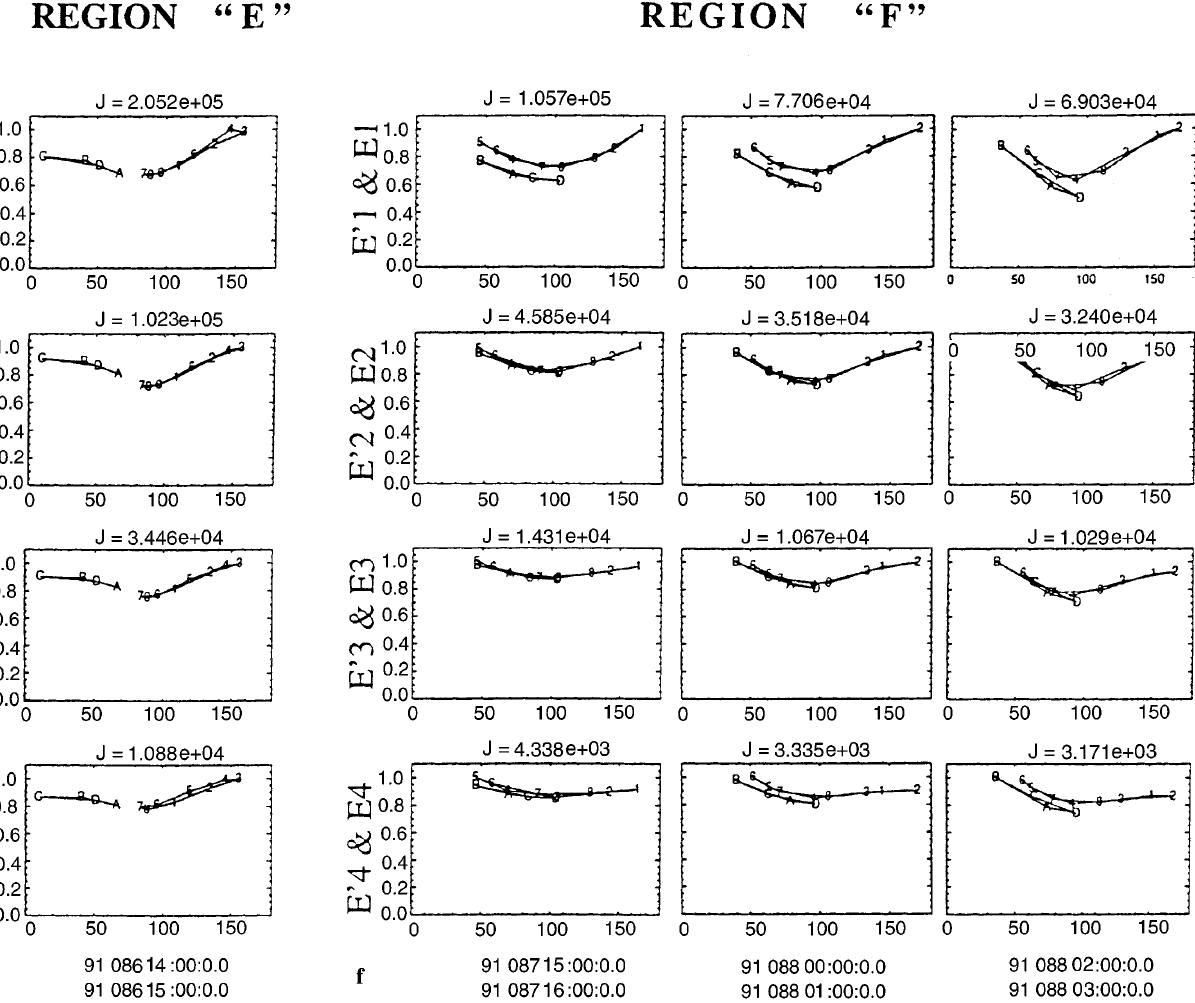
Fig. 2e,f. e The electrons in region E also show a trapping distribution for ~ 3 h within the second ICMEF. f Representative electron PAD plots for region F where strong and persistent bi-directionalities indicate the trapping of